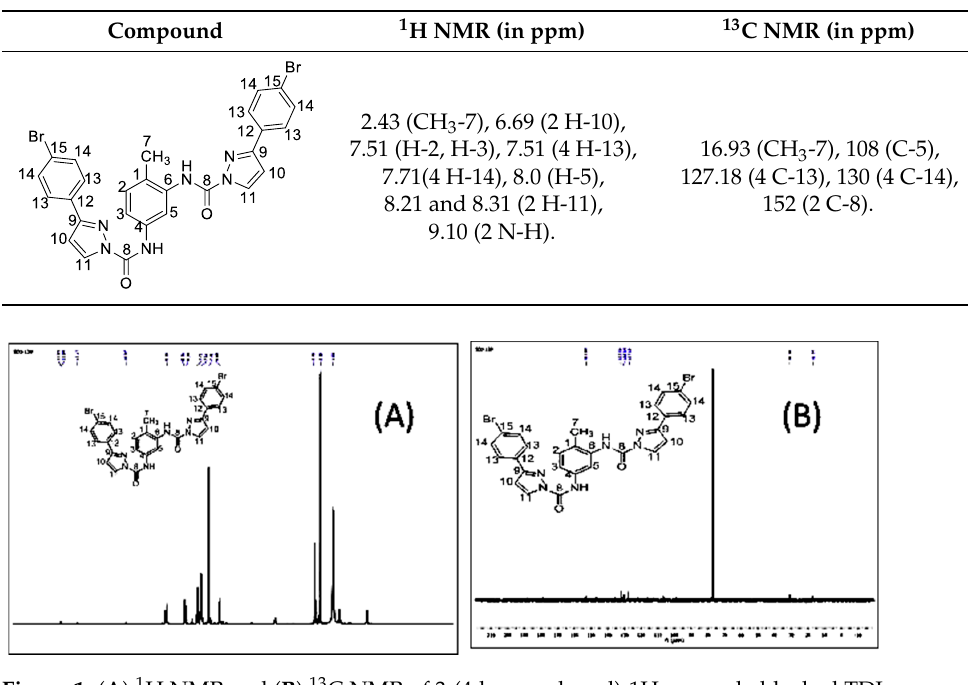
Figure 1. ( A ) 1 H NMR and ( B ) 13 C NMR of 3-(4-bromophenyl)-1H-pyrazole-blocked TDI. Table 4. NMR spectra of polyurethane from blocked TDIwith3-(4-bromophenyl)-1H-pyrazole. Compound